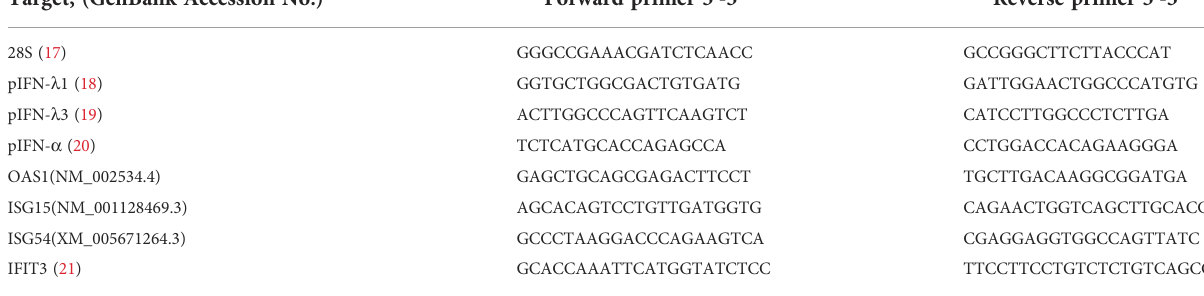
TABLE 1 Forward and reverse primer sequences used in real-time PCR assays. Target, (GenBank Accession